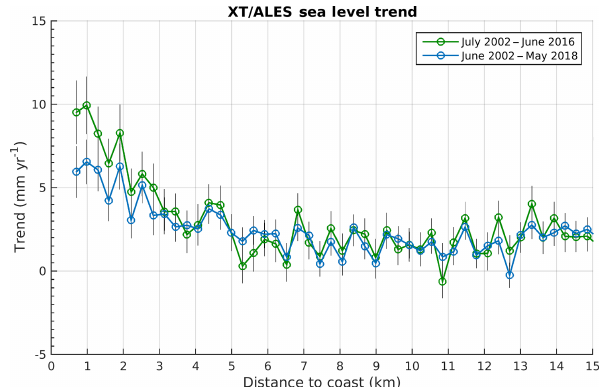
Figure 20. Altimetry-based sea level trends at Senetosa over two periods: (1) July 2002–June 2016, green curve, and (2) June 2002– May 2018, blue curve. Black vertical bars correspond to trend un-